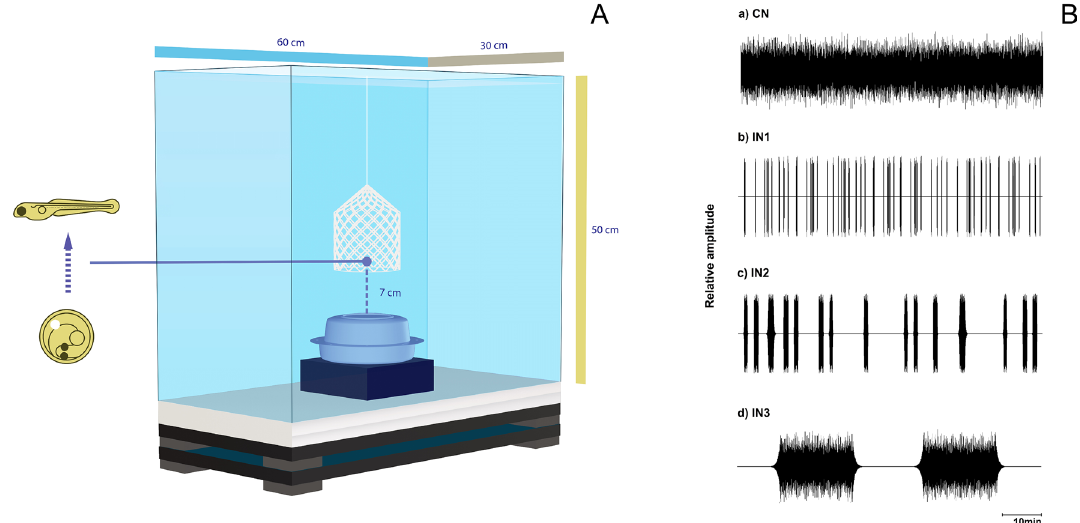
Figure 6. ( A ) Diagram of the acoustic treatment tank. The tank rested on top of two granite plaques separated by anti-vibratory rubber pads. Inside, a custom-made net cylinder containing zebrafish egg/larvae was suspended 7 cm above an underwater speaker (UW30, Lubel Labs, Ohio, USA) that rested on top of a polyurethane sponge. ( B ) Oscillogram of sound files used for playbacks. Control- silent conditions, CN- continuous noise at either 130 (CN 130 ) or 150 dB re 1 μPa (CN 150 ), IN- intermittent regime with random short noise segments (IN1): 5–12 s duration spaced by silent intervals of 1–120 s (total noise exposure of c. 15%); medium noise segments (IN2): 30–60 s interspaced by 1–10 min silence (similar noise exposure to IN1); and long noise segments (IN3) of 15 min separated by 15 min silent periods (about 50% overall noise). Illustration was created using Adobe Illustrator CC 2020 version 24.0.2 for Windows, Adobe Inc., CA, USA and Blender version 2.80 for Windows, Blender Foundation, AMS, no playback. The background noise level measured in such control condition varied between 103 and 108 dB re. 1 µPa (LZS, RMS sound level obtained with slow time and linear frequency weightings: 6.3 Hz–20 kHz). Sound treatments consisted of white noise low-pass filtered at 1500 Hz and adjusted to the tank acoustic prop- erties using Adobe Audition software tools to deliver a relative flat spectrum. To test for the effects of amplitude on larval zebrafish, two sound files of continuous white noise (CN) at different amplitudes or Sound Pressure Levels (SPLs), namely 130 dB (CN 130 ) and 150 dB re. 1 µPa (CN 150 ), were generated and played back in loop. These noise levels were similar to those found in freshwater aquatic habitats characterized by anthropogenic noise activity such as shipping 103,104 and noise conditions in certain zebrafish housing systems 55 . To evaluate the impact of different noise temporal regimes, three additional sound files of intermittent noise and 60 min dura- tion were generated and played back in loop at 150 dB re 1 µPa (Fig. 6B): IN1- short noise segments of 5–12 s duration spaced by silent intervals of 1–120 s (60 noise events per hour) reaching an overall noise exposure of about 15%, designed to mimic intense boat traffic noise as described in Nichols et al. (2015) 95 ; IN2- medium noise segments of 30–60 s interspaced by 1–10 min silence, with 15 noise segments per hour and similar overall noise exposure to IN1; and IN3- long noise segments of 15 min separated by 15 min silent periods (about 50% overall noise), which followed a prolonged shipping activity as described by Nedelec et al. (2015) 13 (Fig. 6B). All noise presentations contained a logarithmic fade-in and fade-out ramps of 10% of the noise presentation. We used random exposure regimes since it reflects better an acoustic environment characterized by traffic noise and it is known to cause physiological stress in fish 13,95 , and affect specifically zebrafish behaviour 105 . Noise levels were calibrated before each experimental trial so that the intended sound level (LZS, 6.3 Hz – 20 kHz) was reached at the bottom of the net box (~ 7 cm above the speaker) using a hydrophone (Bruel&Kjær 8104, Naerum, Denmark; frequency range: 0.1 Hz to 120 kHz, sensitivity of − 205 dB re 1 V/µPa) connected to a hand-held sound level meter (Bruel&Kjær model 2270). Additionally, the acoustic treatments were calibrated with a tri-axial accelerometer (M20-040, frequency range: 1–3 kHz, GeoSpectrum Technolo- gies, Dartmouth, Canada). The particle acceleration sensor was placed horizontally with the acoustic center also positioned at about 7 cm from the speaker in the position occupied by the net box containing the specimens. Particle acceleration level determined for the highest sound level (150 dB re 1 µPa) in the vertical axis consisted of 120 dB/s 2 . A decrease of 20 dB in sound pressure resulted in similar variation in acceleration. The sound play- backs generated most energy in the vertical axis compared to the other orthogonal directions. The calibration was conducted using a Matlab script (paPAM) based on Nedelec et al. (2016) 106 . Morphological and cardiac rate measurements. The impact of the acoustic treatments on morpho- logical development and cardiac rate of larval zebrafish was assessed based on 5 specimens per treatment in each experimental trial. The specimens were lightly sedated using low concentration (0.004%) of MS-222 buffered with sodium bicarbonate to quantify cardiac activity following previously described procedures 107 , and then observed under a stereomicroscope (Stemi 2000CS, Carl Zeiss, Jena, Germany) connected to a digital camera